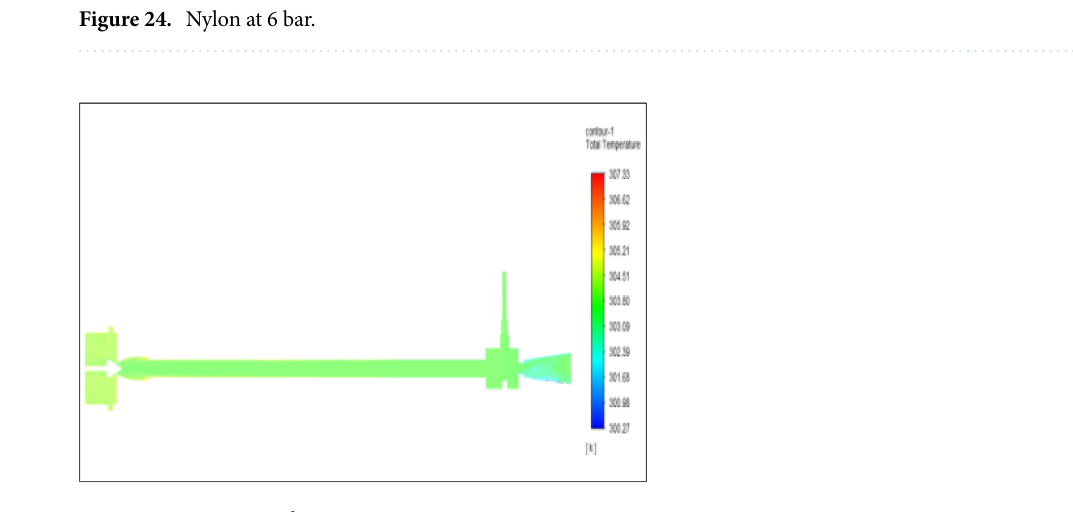
Figure 25. Bronze at 6